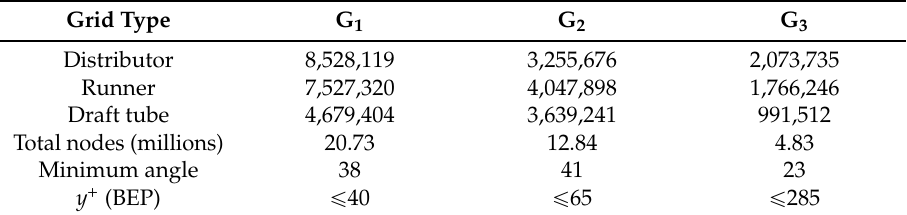
Table 3. Mesh densities used in scaling test and quality parameters